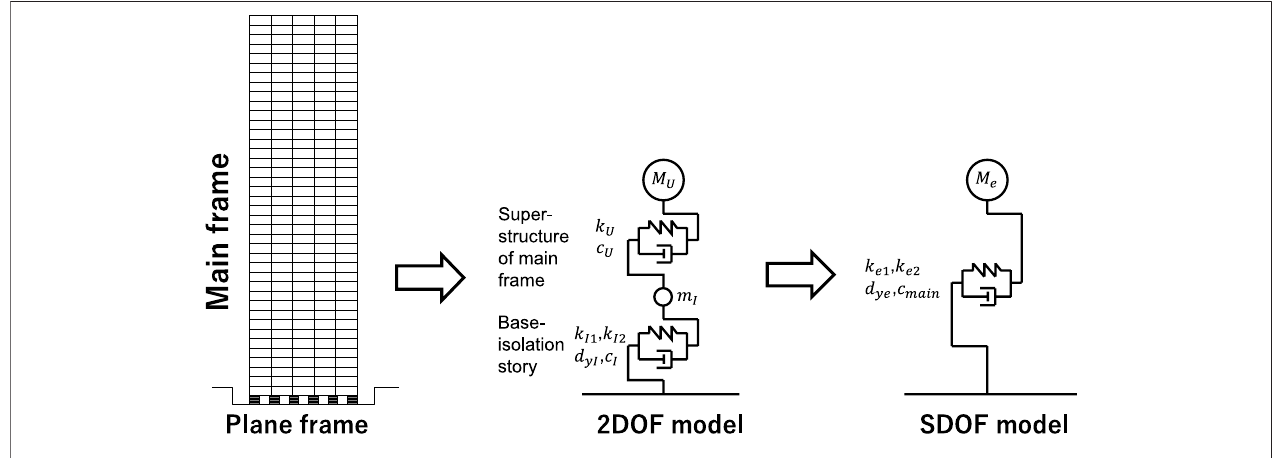
FIGURE 3 | Reduction of base-isolated tall plane frame into SDOF